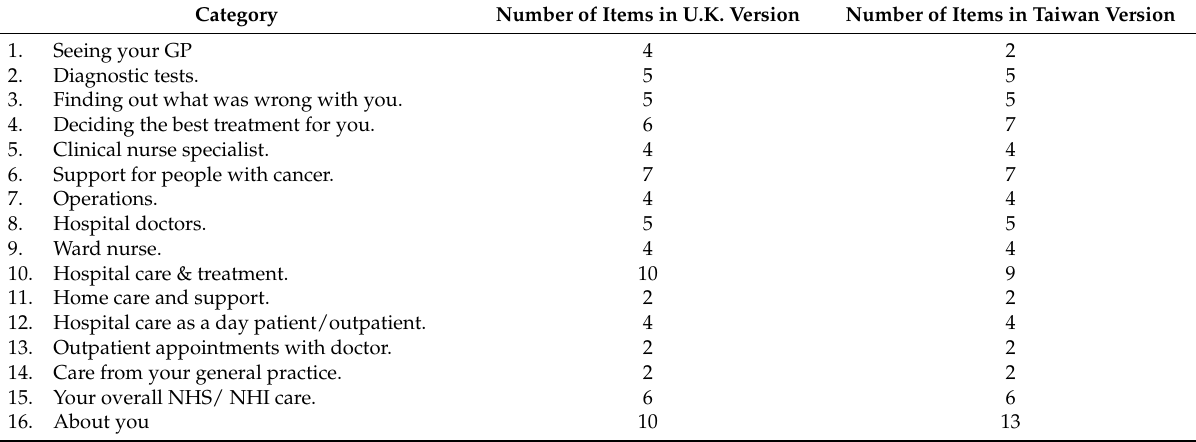
Table 2. Comparison between U.K. and Taiwan versions of Cancer Patient Experience